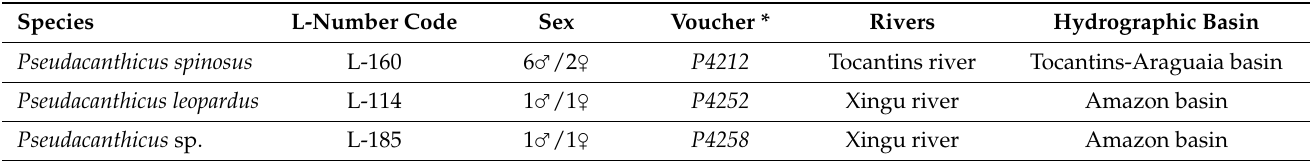
Table 1. Samples of Pseudacanthicus species analyzed in this